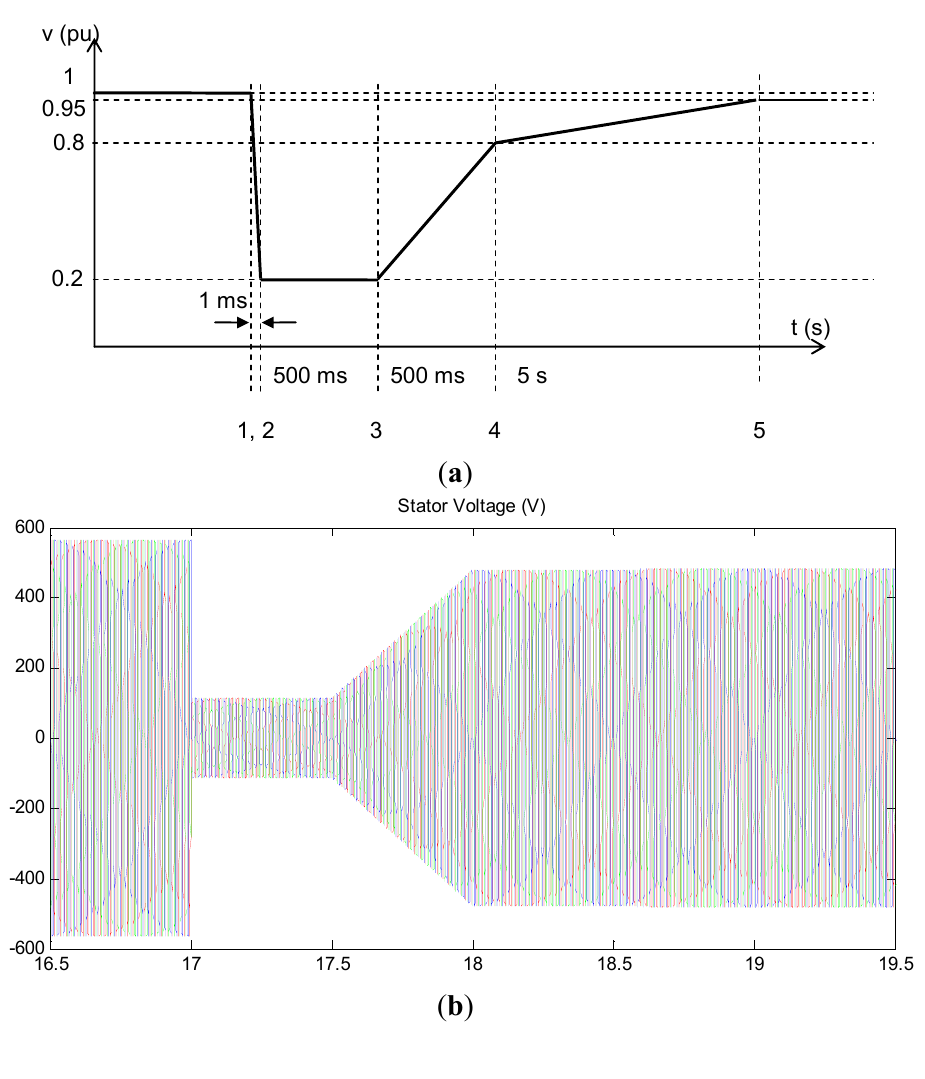
Figure 6. ( a ) Spanish Grid Code pattern for voltage sag profile and ( b ) voltage sag used in